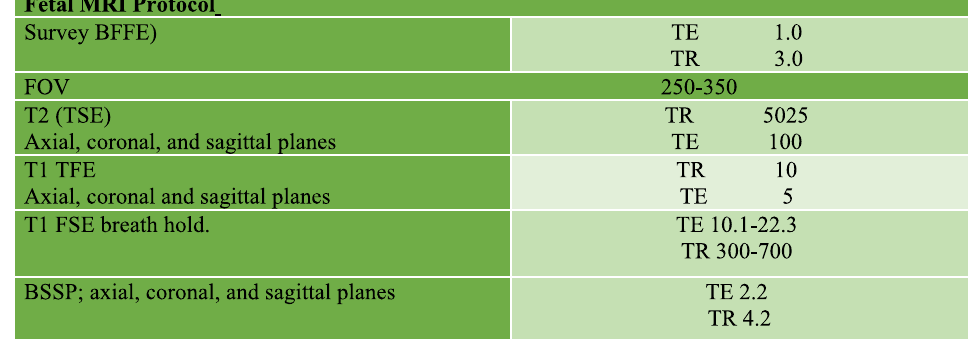
Table 1 MRI techniques used in our